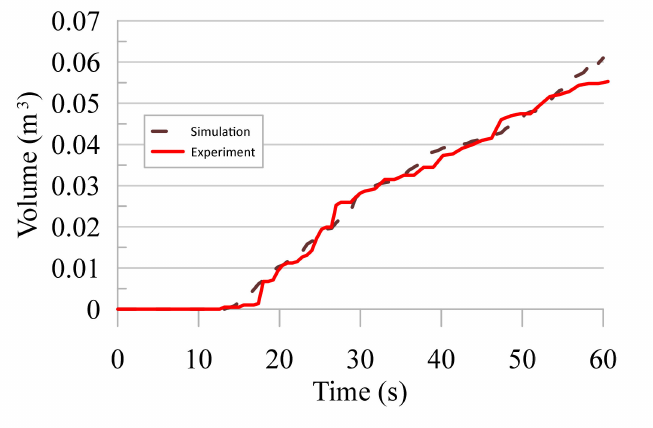
Figure 15. Time series comparison of overtopping volumes between simulation and experiment for R2.